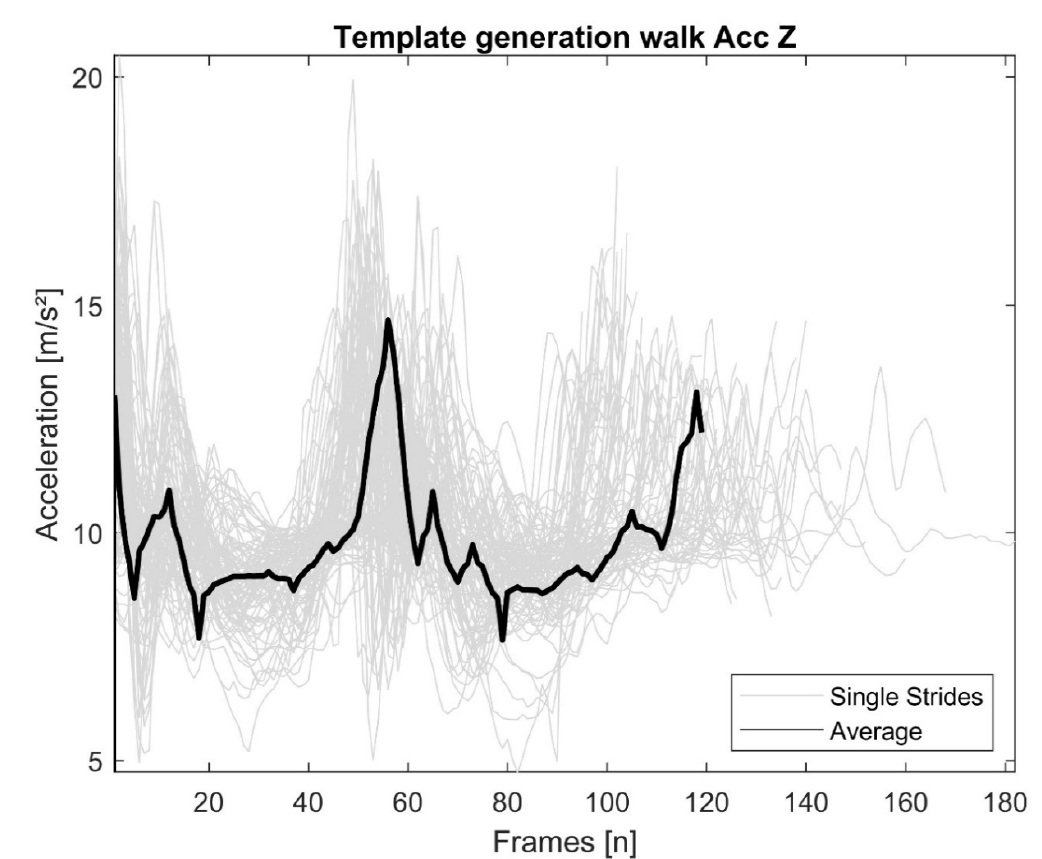
Figure 2. Overlay of walking stride snippets and the resulting average template calculated by the dynamic time warping (DTW) averaging method [19].